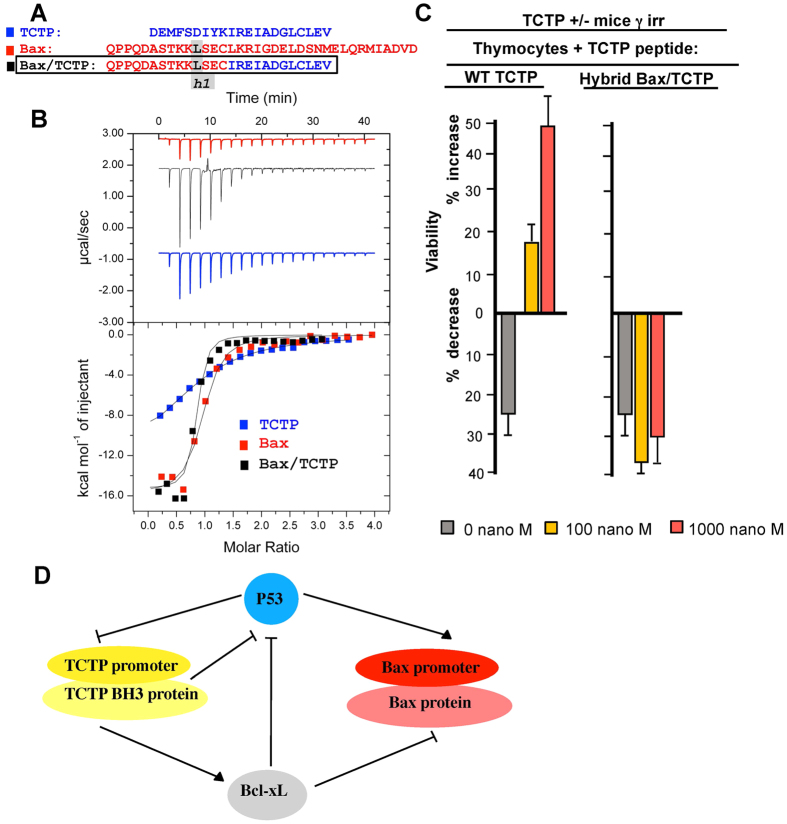
Molecular/functional analysis of the h1 (P1) subregion of BH3-TCTP.(A) The three BH3 peptides (TCTP in blue, Bax in red and the hybrid Bax/TCTP aligned with the h1 subregion framed). (B) Interaction between Bcl-xL and TCTP-BH3, or Bax or hybrid Bax/TCTP peptides. Calorimetric titration between Bcl-xL (0.043 mM) and increasing amount of TCTP-BH3 (0.75 mM) (blue curve); Bcl-xL (0.006 mM) and increasing amount of Bax (0.117 mM) (red curve); Bcl-xL (0.043 mM) and increasing amount of hybrid Bax/TCTP (0.65 mM) (black curve); Each experiment was carried at 30 °C in 50 mM ammonium bicarbonate pH 9. (C) Thymocytes from TCTP+/− mice were γ-irradiated (γ-irr) (2.5 Gy) and cultured in the presence of WT TCTP1–31 peptide, hybrid Bax/TCTP peptide at the indicated concentrations ranging from 0 to 1000 nM. (D) Schematic representation of the TCTP/Bcl-xL interaction in the context of the reciprocal feedback loop between P53 and TCTP, sequestering of P53 by Bcl-xL and the control of Bax.